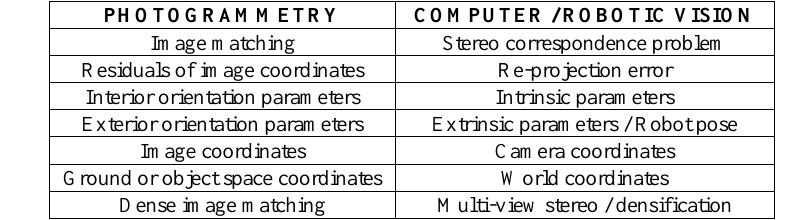
Table 1: Examples of dictionary entries (adapted from Granshaw & Fraser,